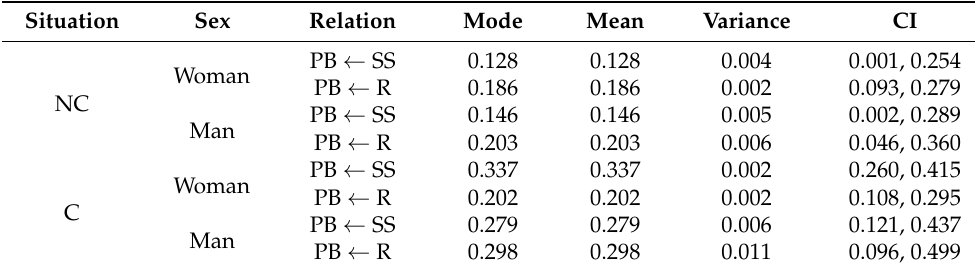
Table 3. Bayesian estimates of regression